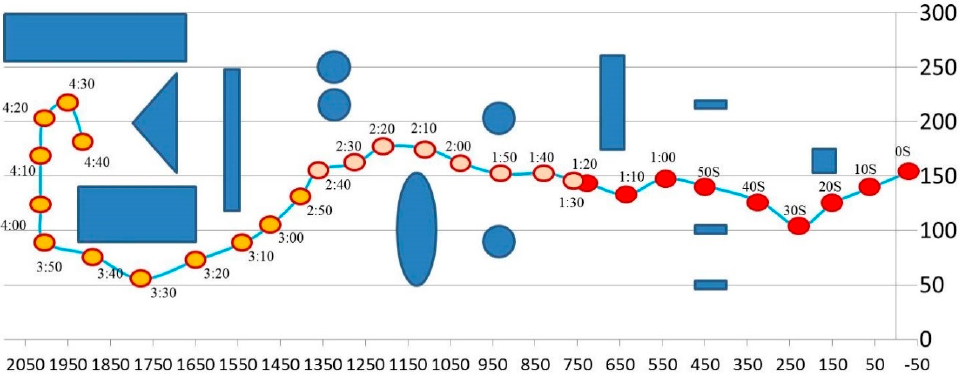
Figure 16. The path the robot took with positions taken at 10 s interval.